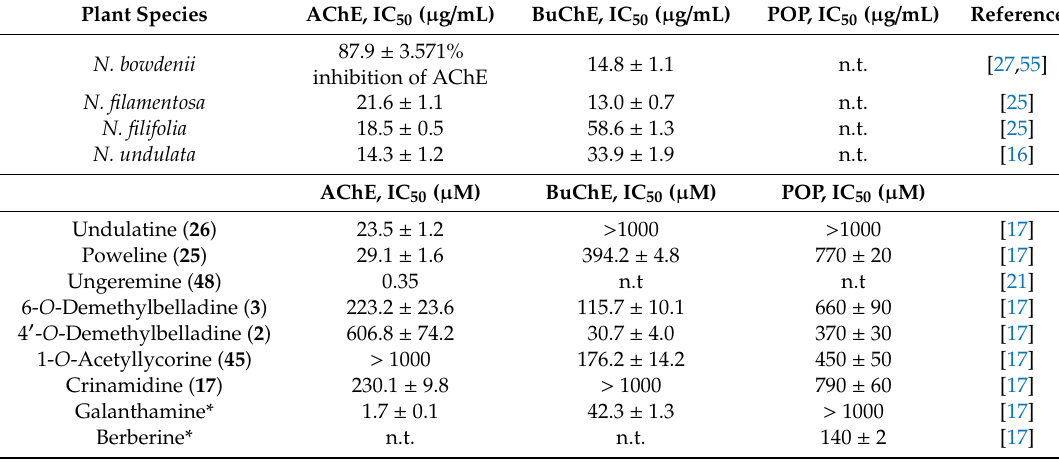
Table 2. AChE, BuChE, and POP inhibitory activity of the alkaloidal extracts of Nerine species and isolated